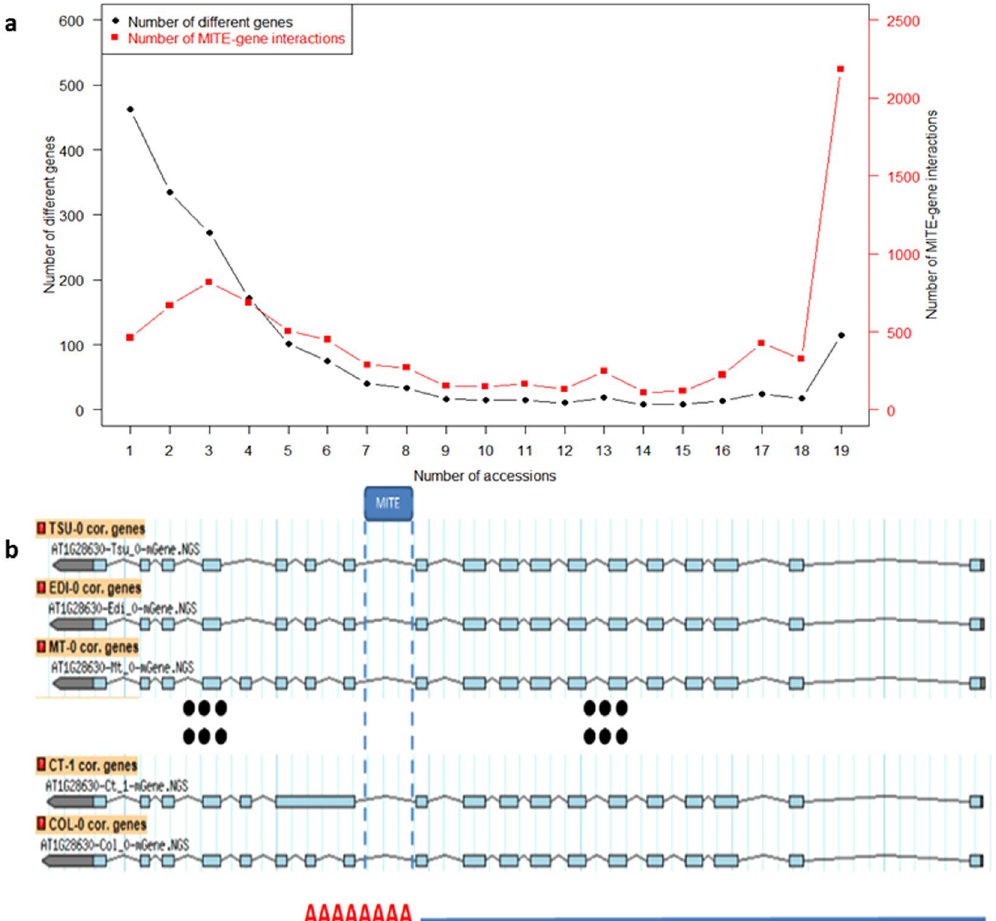
Figure 4. Summary of the MITE-gene interactions. ( a ) The shared MITE-gene interaction in 19 Arabidopsis accessions. The X-axis represents the number of different accessions that share the same MITE-gene interaction. The left Y-axis (black) represents the number of MITE-related genes. The MITE-related genes are defined as those that contain or are adjacent to the same MITEs in at least one accession. The right Y-axis (red) presents MITE-gene interaction values, which are defined and quantified as the production of multiplying the number of MITE-related genes with the number of accessions having the same MITE-related genes. For instance, the first MITE-gene interaction value is 462 (weak interaction), which means there are 462 MITE-related genes present only in one accession. The last MITE-gene interaction value is 2185 (strong interaction), which means there are 115 MITE-related genes common in all 19 accessions. ( b ) The snapshot of MITE-gene interactions associated with gene